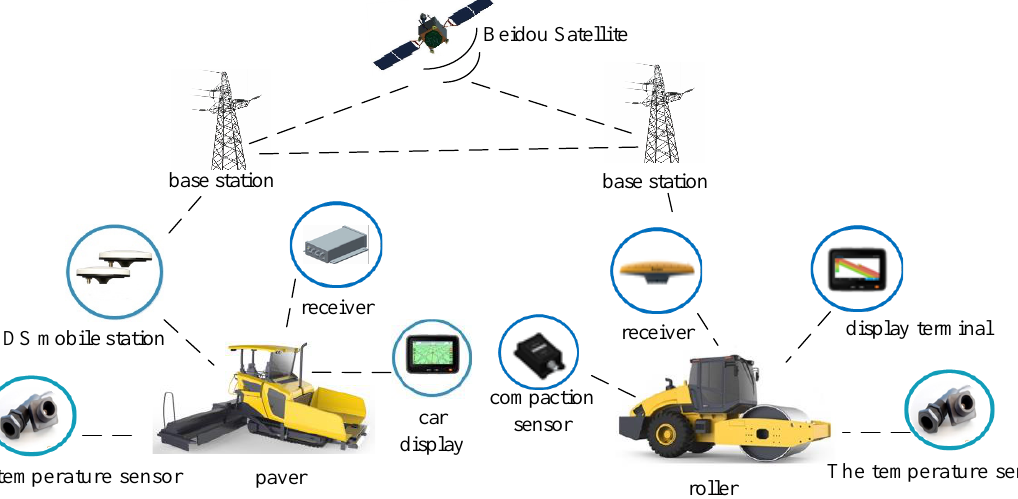
Figure 3. System architecture of the asphalt mixture transportation monitoring system.